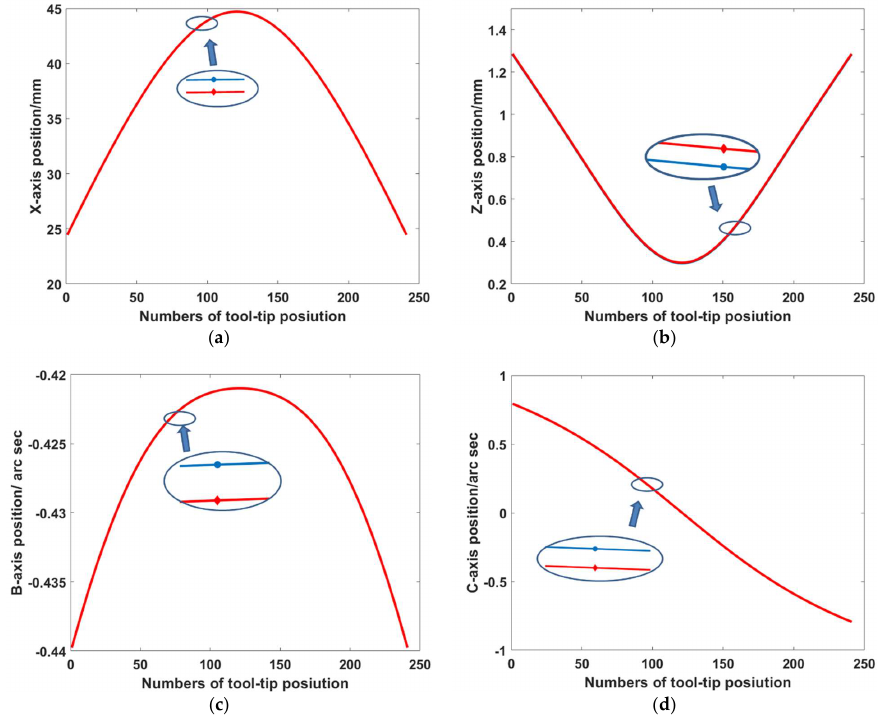
Figure 13. Axis position obtained from the kinematic structure with geometric error (the red line represents the original position of each axis calculated from the theoretical kinematic relation and the blue line represents the compensated trajectory position of each axis). ( a ) X -axis position considering geometric error. ( b ) Z -axis position considering geometric error. ( c ) B -axis position considering geometric error. ( d ) C -axis position considering geometric error.